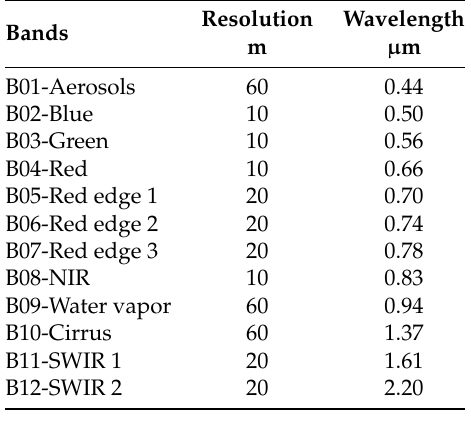
Table 1. The used spectral bands of Sentinel-2.